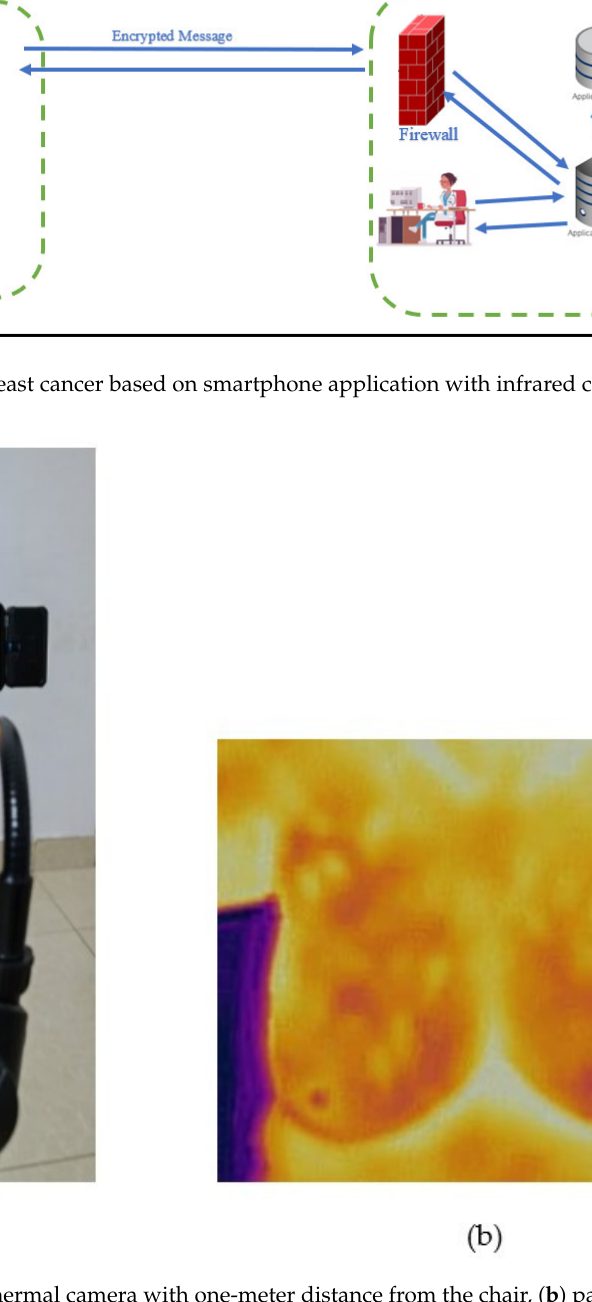
Figure 2. Examination room ( a ) thermal camera with one-meter distance from the chair, ( b ) patient exam.